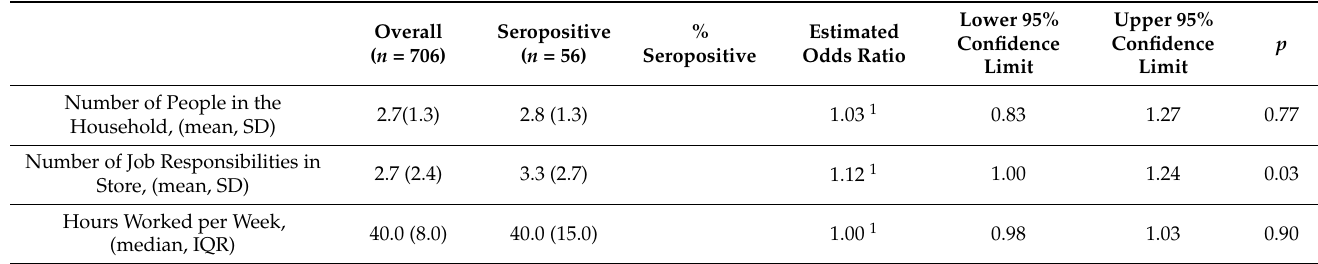
Figure 1. Map of tested study participants by county.